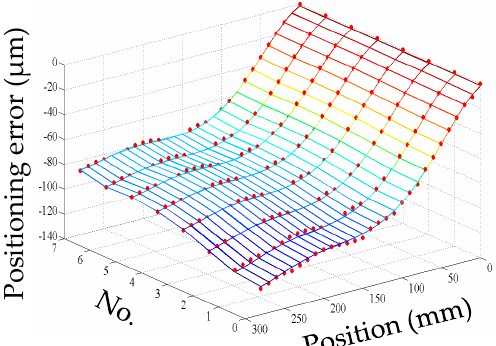
Figure 13. The fitting results of the artificial neural network (ANN) model (measured positioning error marked with dots) in experiment I.